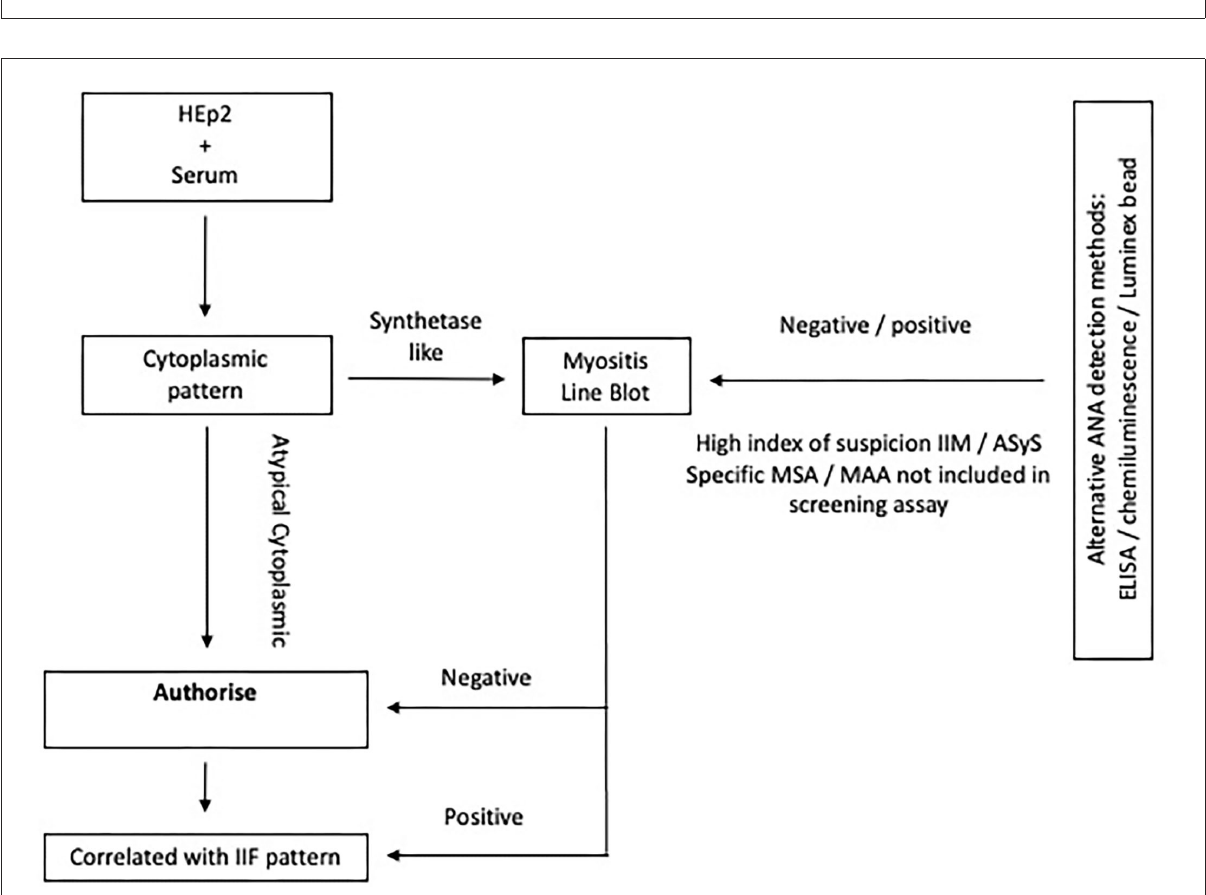
FIGURE4 Indirect immunofluorescence demonstrating “anti-nuclear” antibody bound to (A) Cytoplasm as seen in ASyS; (B) Homogeneous nuclear binding as seen in SLE, autoimmune hepatitis, and juvenile idiopathic arthritis; (C) Centromere binding as seen in limited cutaneous SSc with anti-centromere antibody positivity. Images courtesy of ANApatterns.org—with permission.